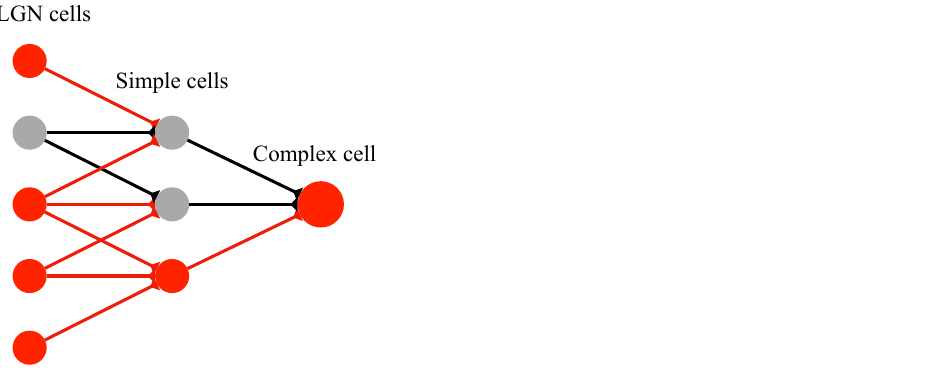
Figure 3. Hubel–Wiesel feedforward model. Effective synapse connections and activated cells are colored red.